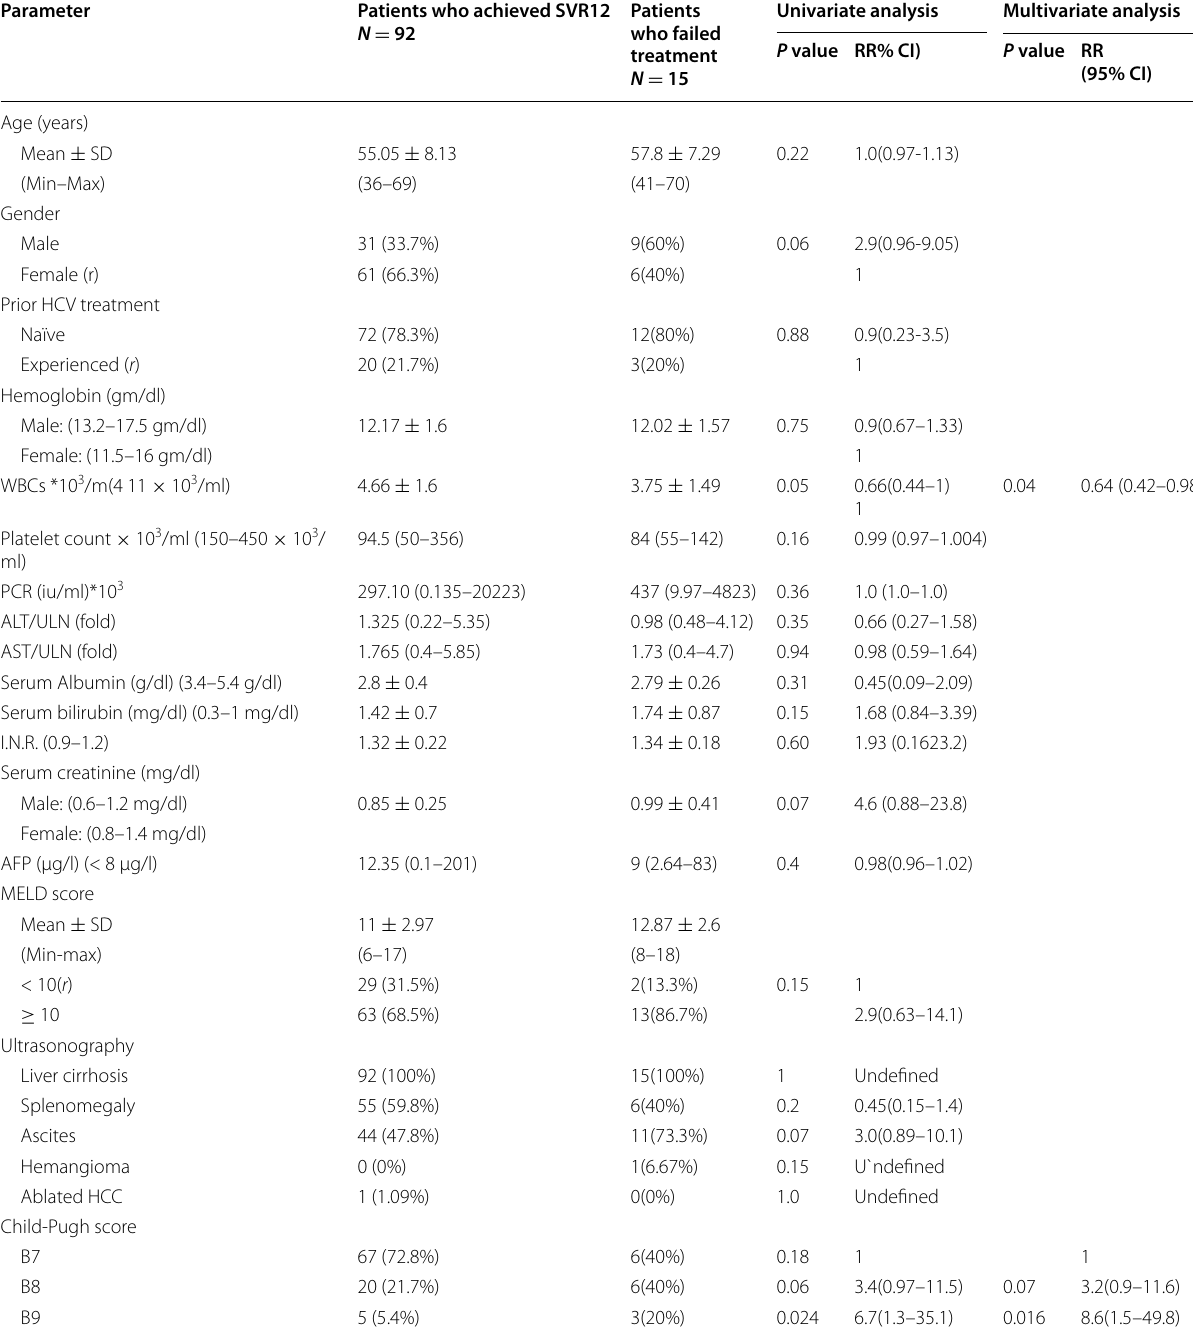
Table 1 Univariate and multivariate analysis of predictors of SVR12 in treated patients